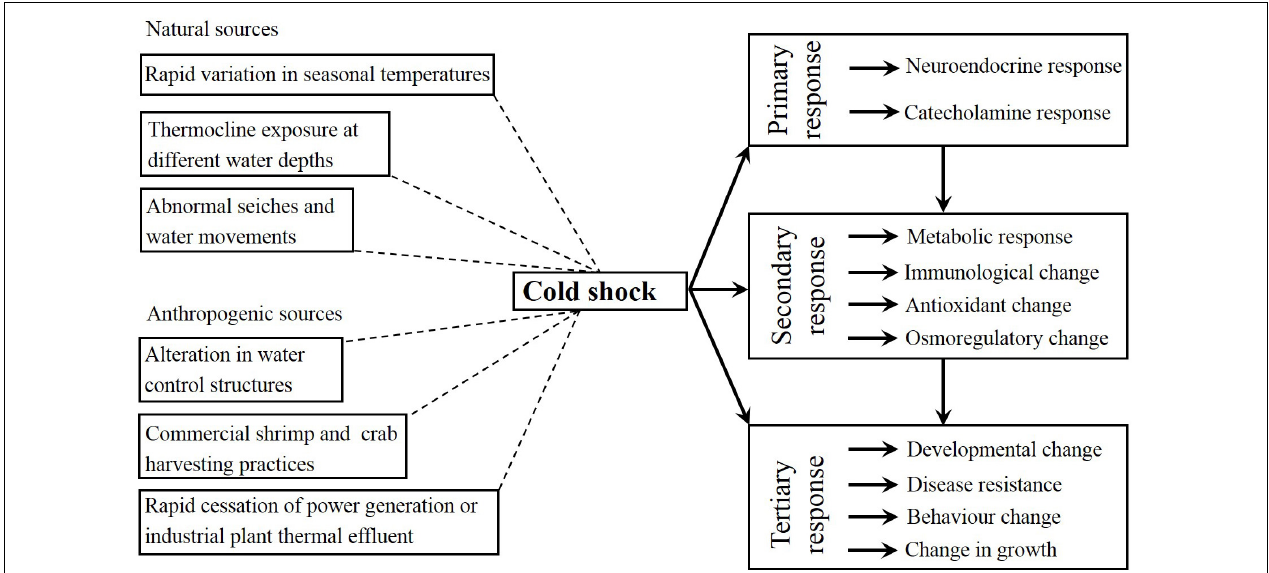
FIGURE 1 | Schematic representation of natural and anthropogenic sources of cold shock and the primary, secondary and tertiary responses to cold